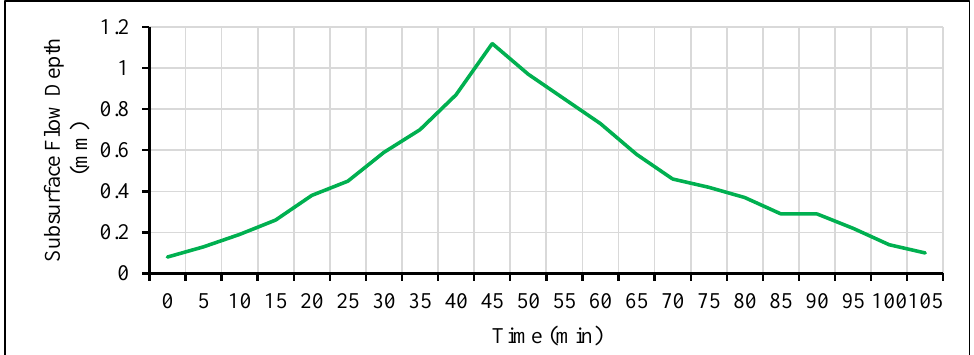
Figure 9. Subsurface flow for rainfall intensity of 100 mm/h for 30 min.